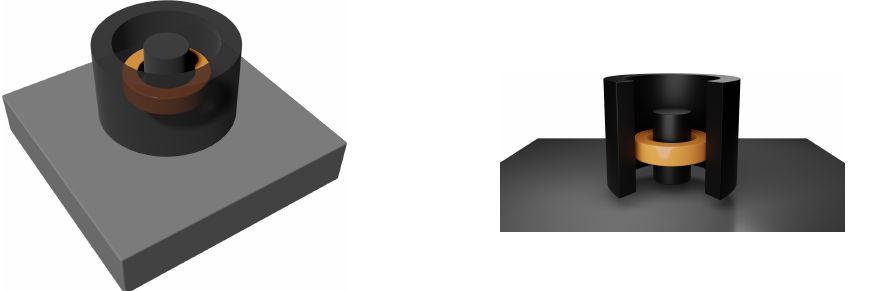
Figure 1. The sensor above the plate. The shield is shown as transparent/cut to show the sensor inside.